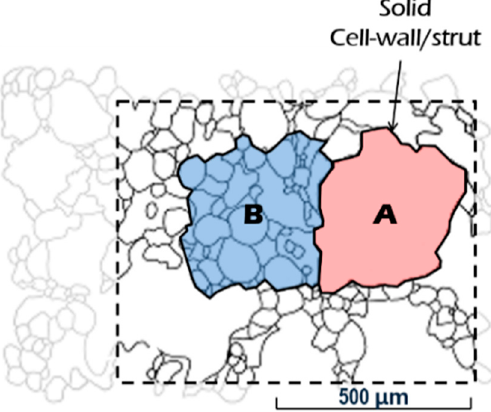
Figure 8. Modelling scheme for the radiation in pores.